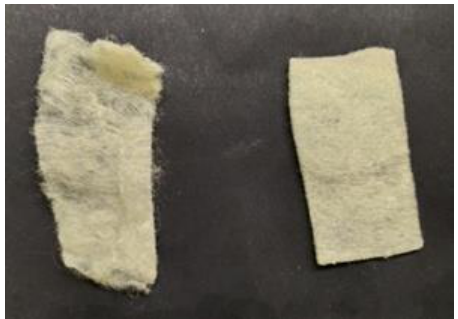
Figure 1. Non-woven material without chitin nanofibrils (ChNF) (left) and the material containing 0.5% ChNF (right).